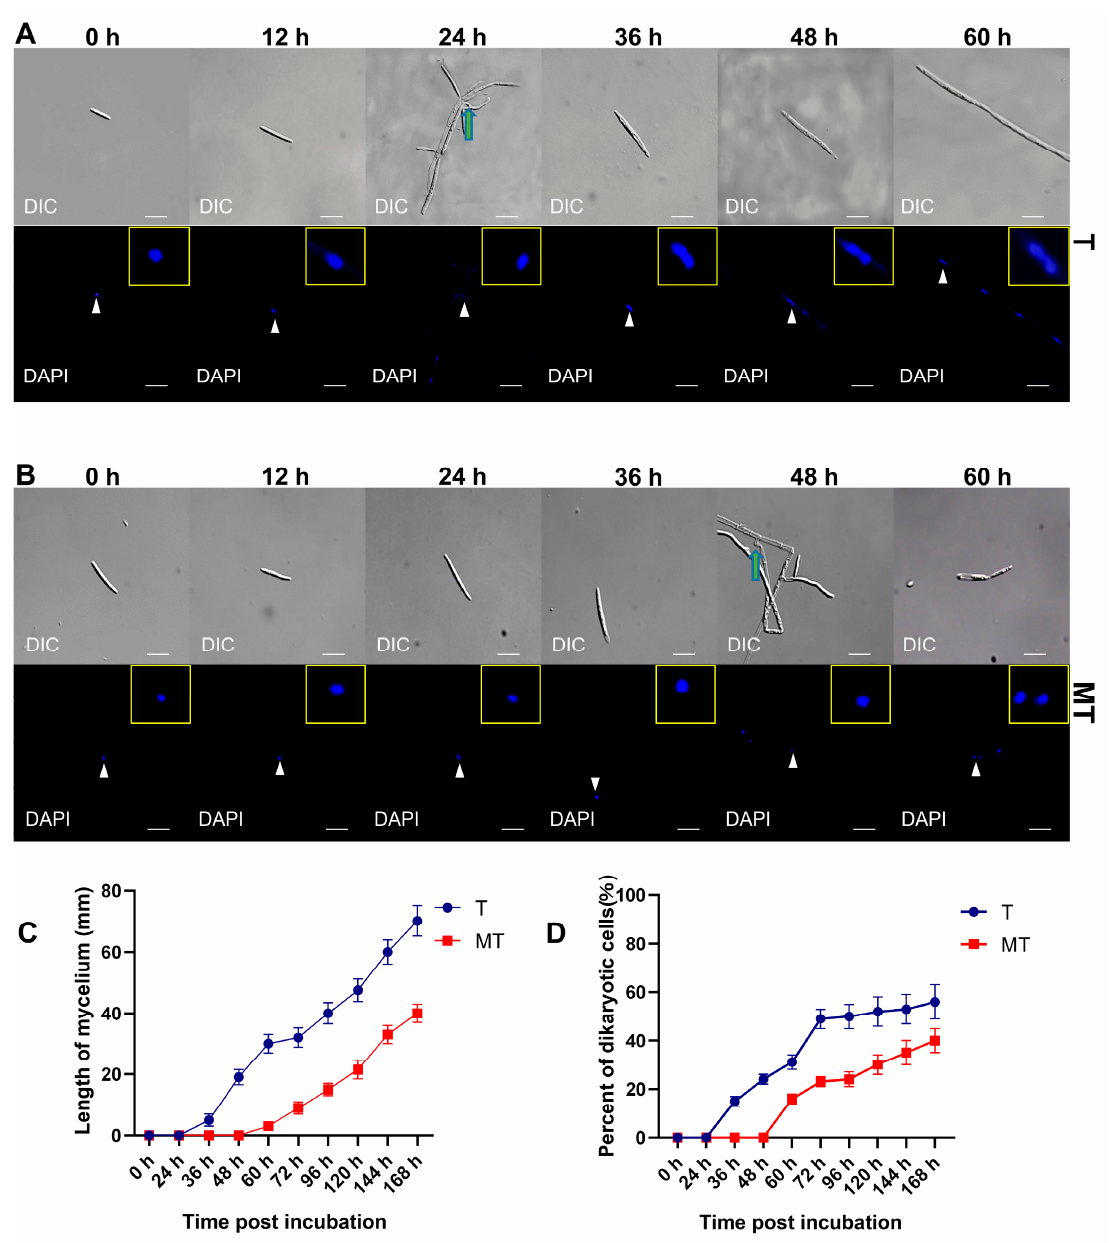
Figure 1. Comparison of the mating process of T- and MT-type U. esculenta . ( A ) The mating process of T-type U. esculenta on YEPS solid medium. ( B ) The mating process of MT-type U. esculenta on YEPS solid medium. Differential interference contrast (DIC) was used to observe the structure of mycelia. Nuclei were stained by DAPI. The conjunction tube is marked with a green arrow. The nucleus, which is enlarged in the upper right of the picture, is marked with a white arrow. The scale bar represents 70 µ m. ( C ) Mycelia length around colonies of T- and MT-type U. esculenta were monitored after 0 to 168 h incubation on YEPS solid medium (Mean ± SD, number of replications = 8). ( D ) Percent of dikaryotic cells. Nuclei were stained by DAPI to distinguish dikaryotic or monokaryonic cells (Mean ± SD, number of replications > 200).